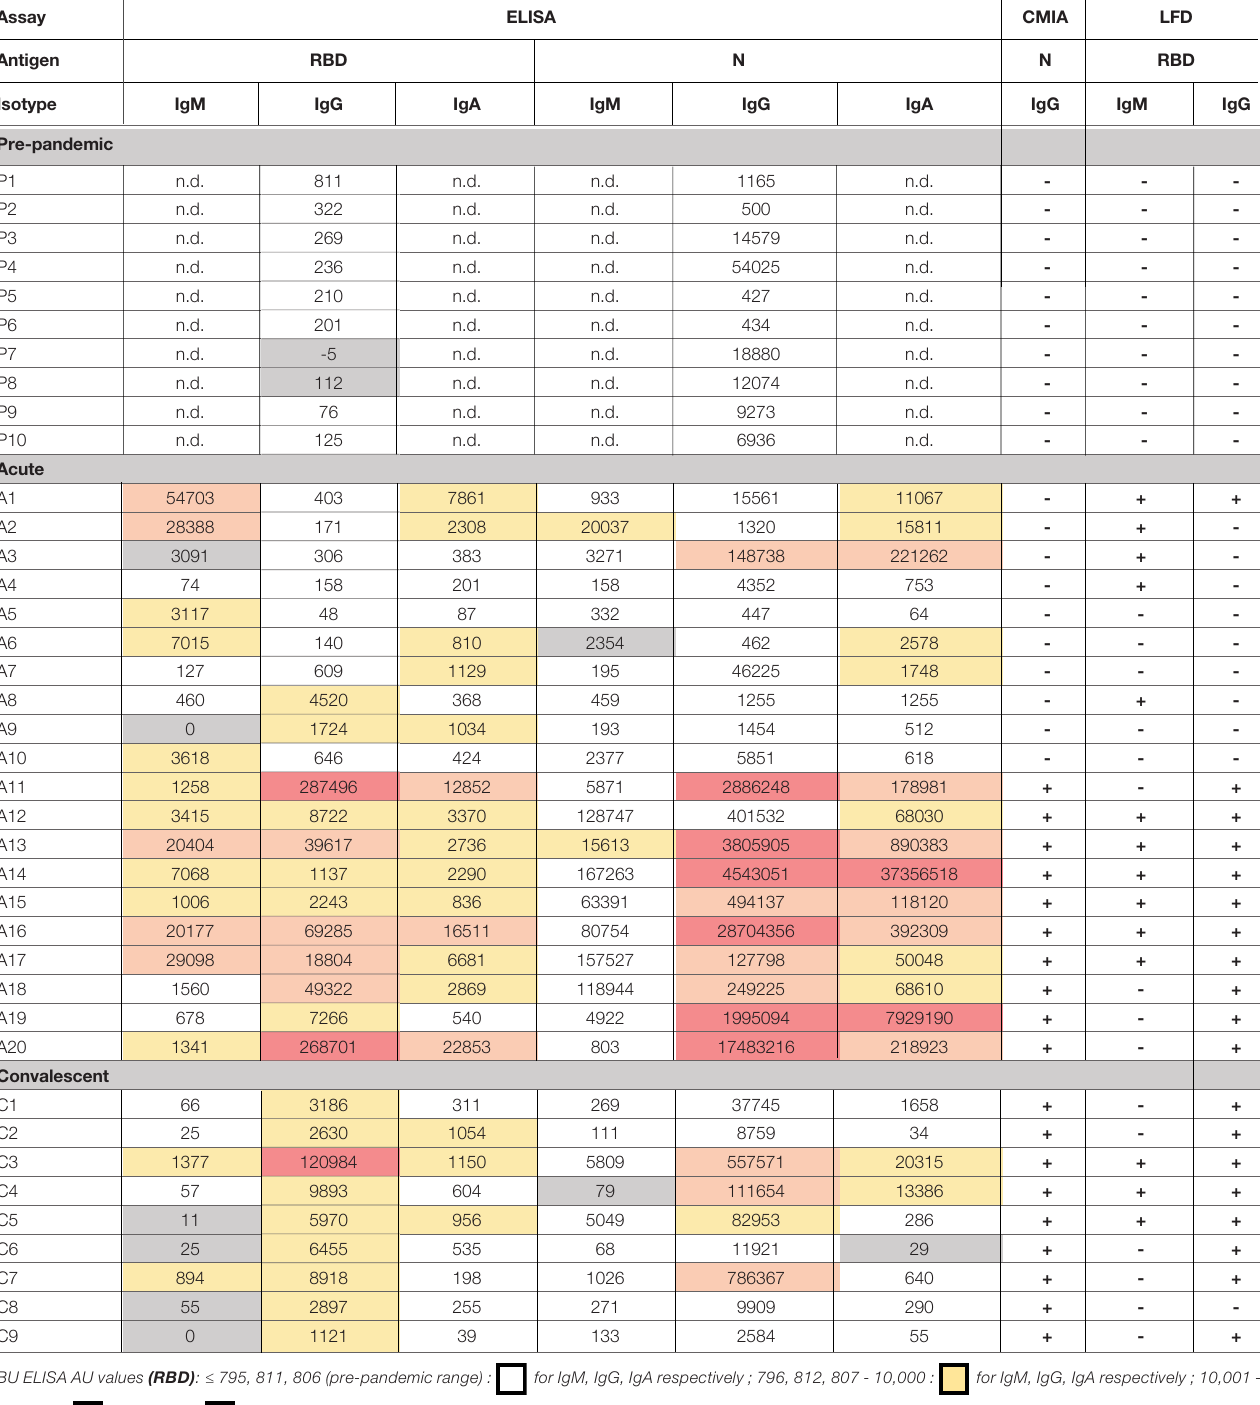
TABLE 2 | Comparison of SARS-CoV-2 reactive antibody results measured by the BU ELISA protocol, the EUA approved Abbott IgG chemiluminescent microparticle assay, and Antagen ’ s lateral fl ow rapid test. Assay ELISA CMIA LFD Antigen RBD N N RBD Isotype IgM IgG IgA Pre-pandemic